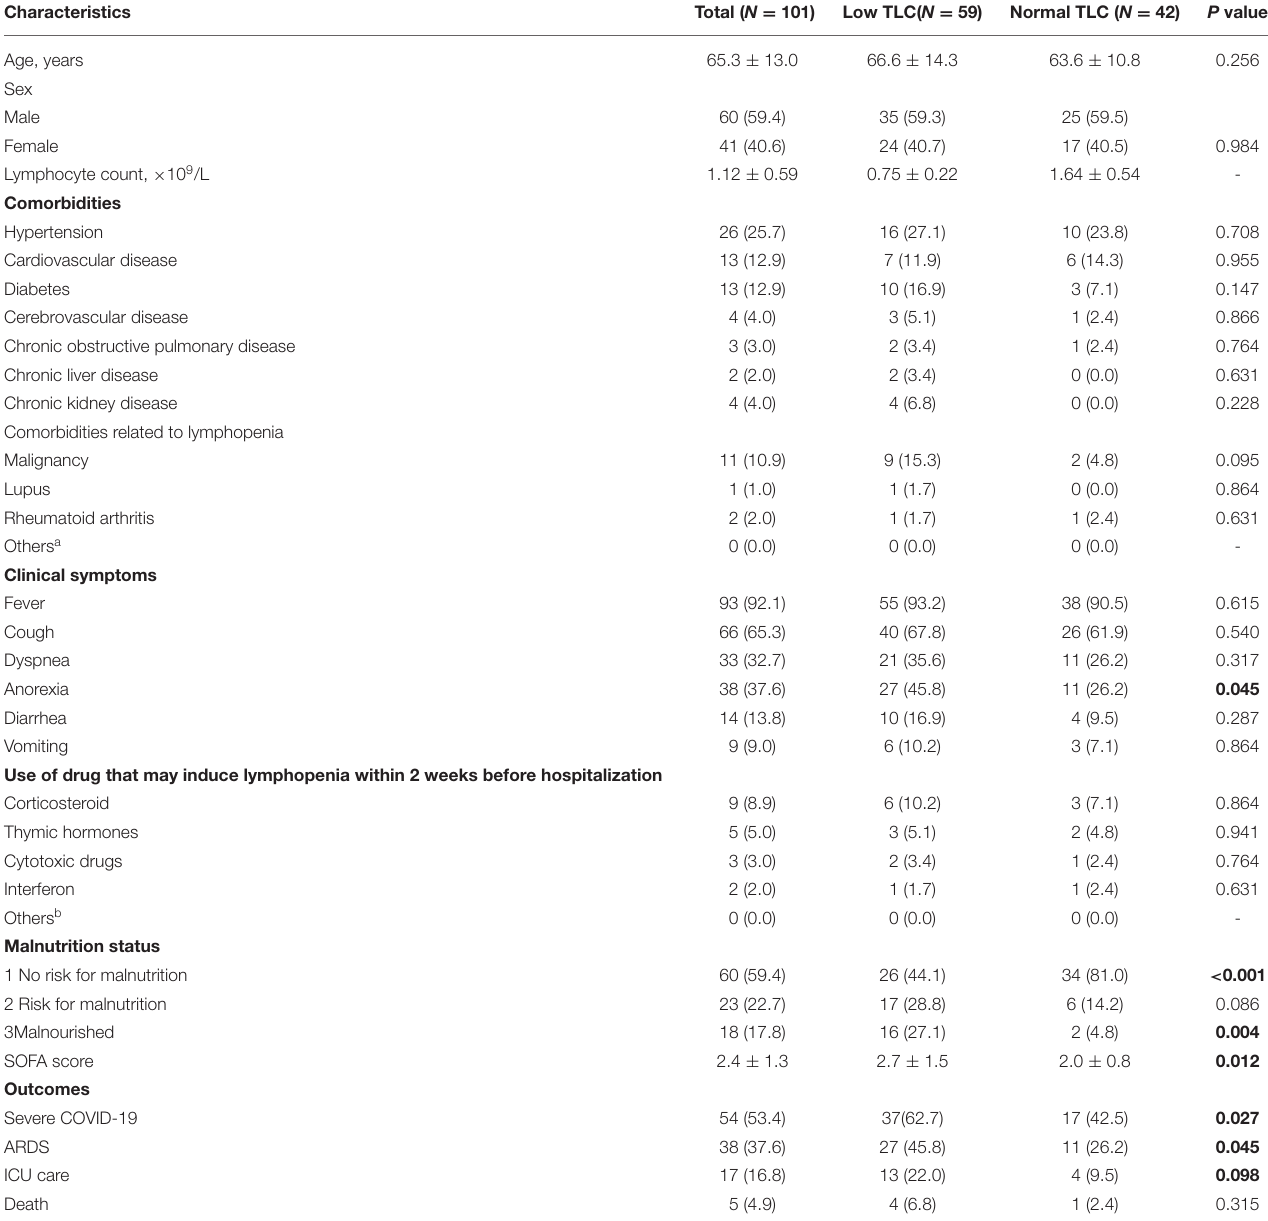
TABLE 1 | Univariate analysis of the risk factors for low TLC in hospitalized patients with early-stage COVID-19.